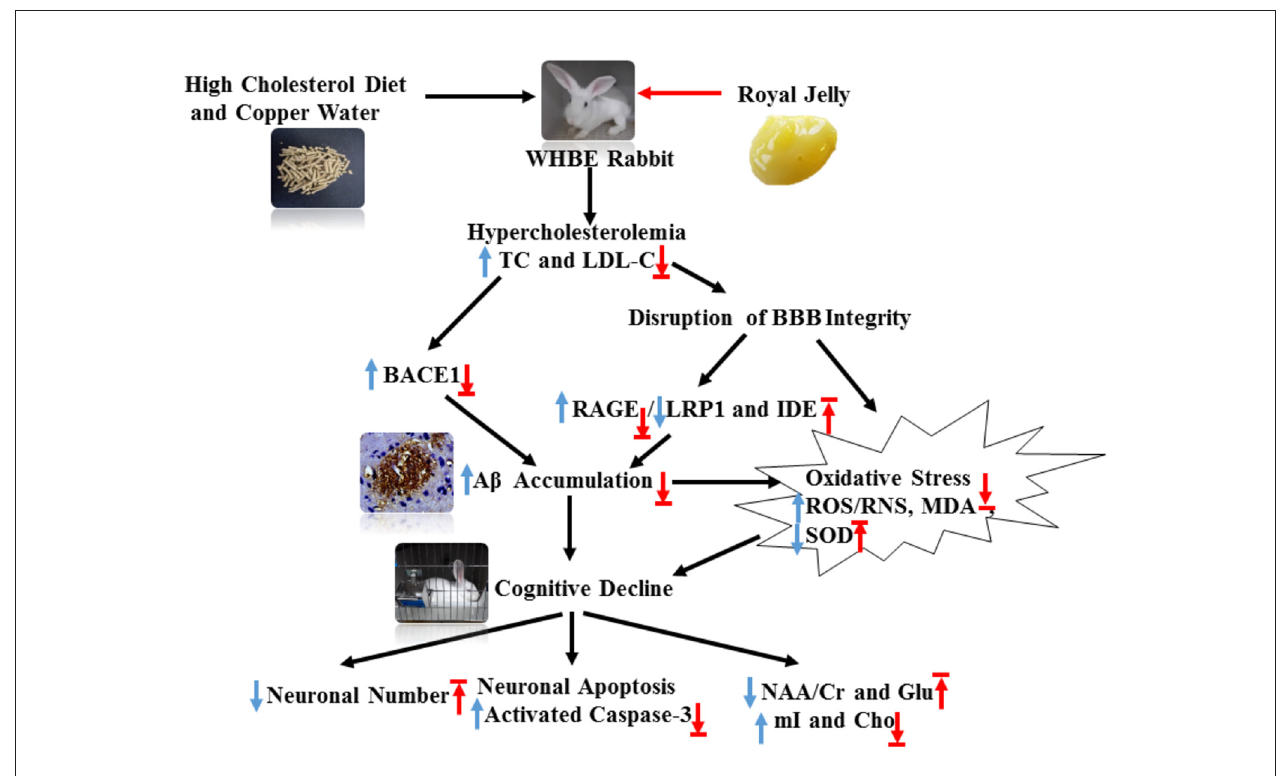
FIGURE 8 | Schematic showing the possible mechanisms by which RJ improves hypercholesterolemia-induced rabbits with AD. AD conditions were induced by feeding rabbits with a high cholesterol diet plus copper in drinking water. RJ can reduce cholesterol levels, down-regulate BACE1 and RAGE expression, increase the expression levels of LRP1 and IDE, promote the degradation and clearance of A β , and finally reduce A β . Moreover, RJ also has anti-oxidative effects, and it enhances neuronal metabolic activities and prevents neuronal loss. TC, total cholesterol; LDL-C, low-density lipoprotein cholesterol; BACE1, β -site APP cleaving enzyme 1; BBB, Blood-brain barrier; RAGE, receptor for advanced glycation end products; LRP1, LDL receptor related protein 1; IDE, insulin-degrading enzyme; A β , amyloid β -protein; ROS, reactive oxygen species; RNS, reactive nitrogen species; MDA, malondialdehyde; SOD, superoxide dismutase; activated caspase-3, activated cysteinyl aspartate specific proteinases 3; NAA, N-acetylaspartata; Glu, glutamate; mI, myo-inositol; Cho, choline. Arrows pointing up or down indicate statistically significant increases or decreases ( p < 0.05). Blue arrows indicate the changes in AD rabbits, while red arrows indicate the treatment effects of